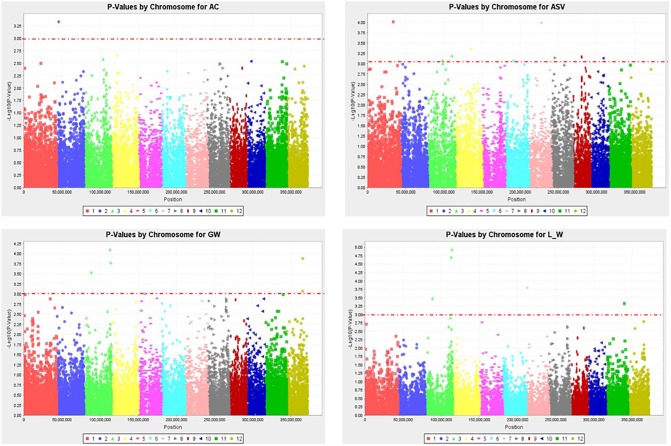
Manhattan plots of GWAS results for grain quality traits (AC, amylose content; ASV, alkali spreading value; GW, grain width; L_W, grain length to width ratio); Threshold = −log10(p−value) > 3.